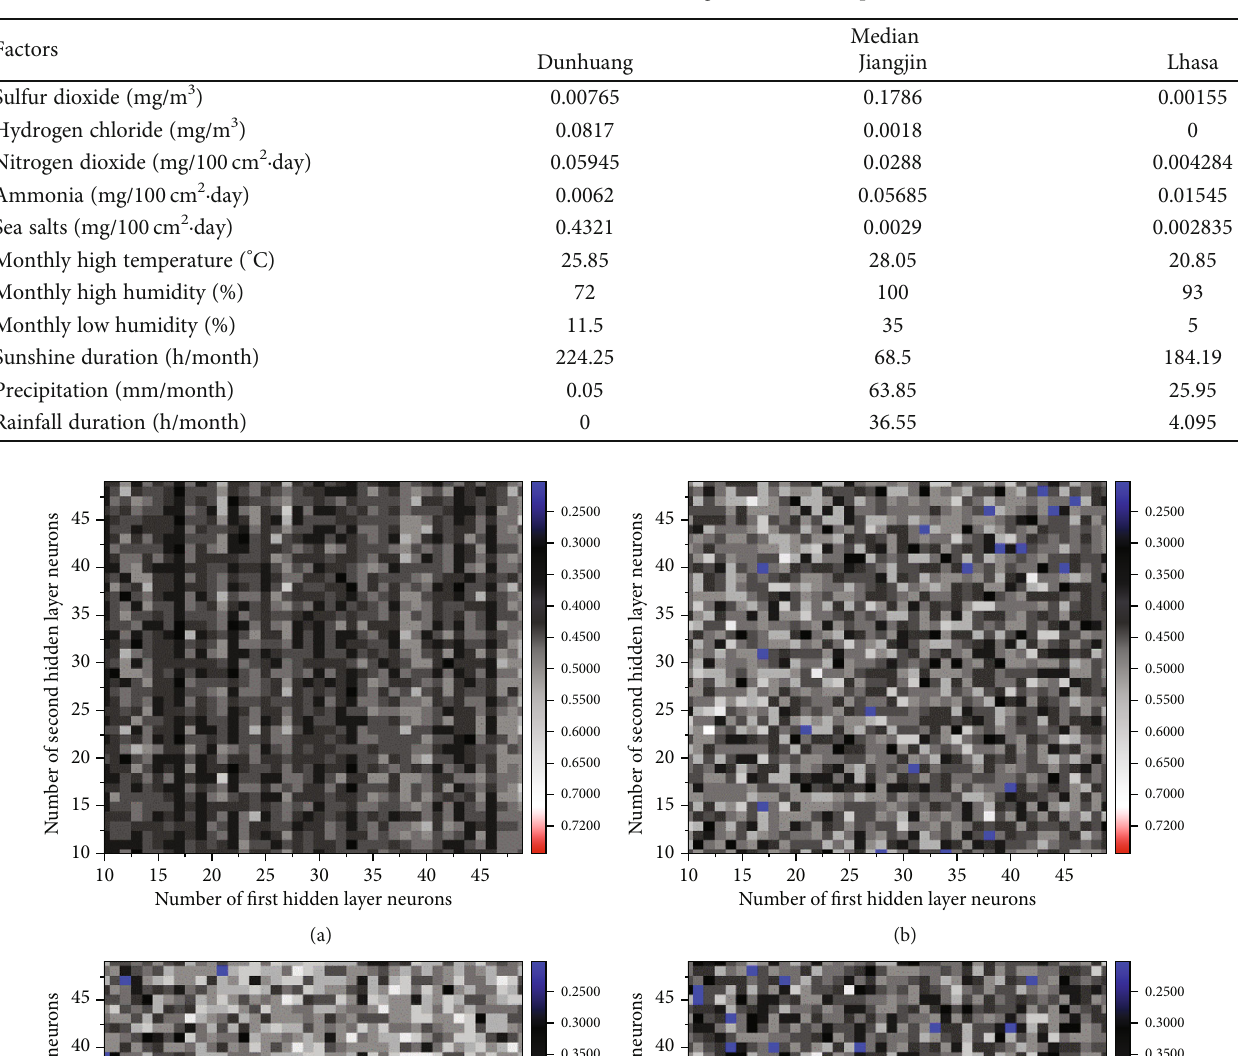
Table 7: Data of the chosen factors from the regions with incomplete data.